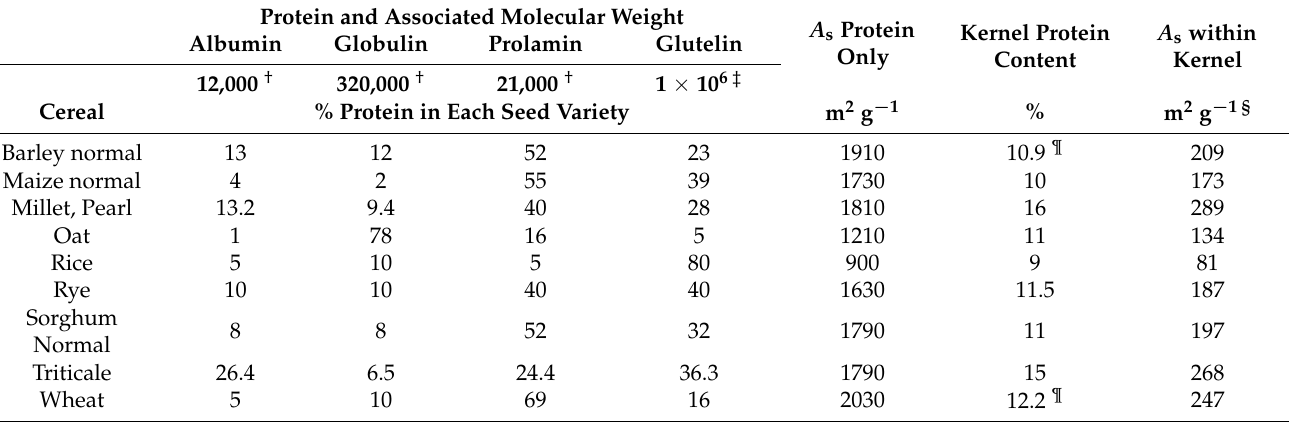
Figure 5. Protein and carbohydrate content of 8 different cereals and legumes versus the dry-basis moisture content at T 1min . Authors Ratkovic and Pissis suggested the water content corresponds to the primary hydration sphere around the macromolecule (digitized from [113]). Table 3. Protein content in different cereal grains [114] and calculated specific surface areas ( A s ) of the protein alone and with respect to the whole